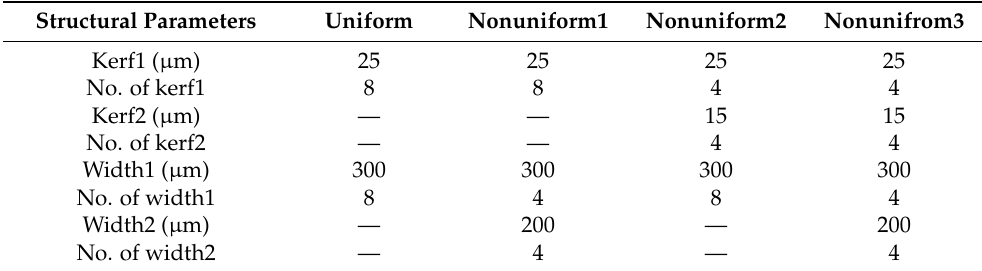
Table 1. The structural parameters of simulation transducer models. Structural Parameters Uniform Nonuniform1 Nonuniform2 Nonunifrom3 Kerf1 ( µ m) — —